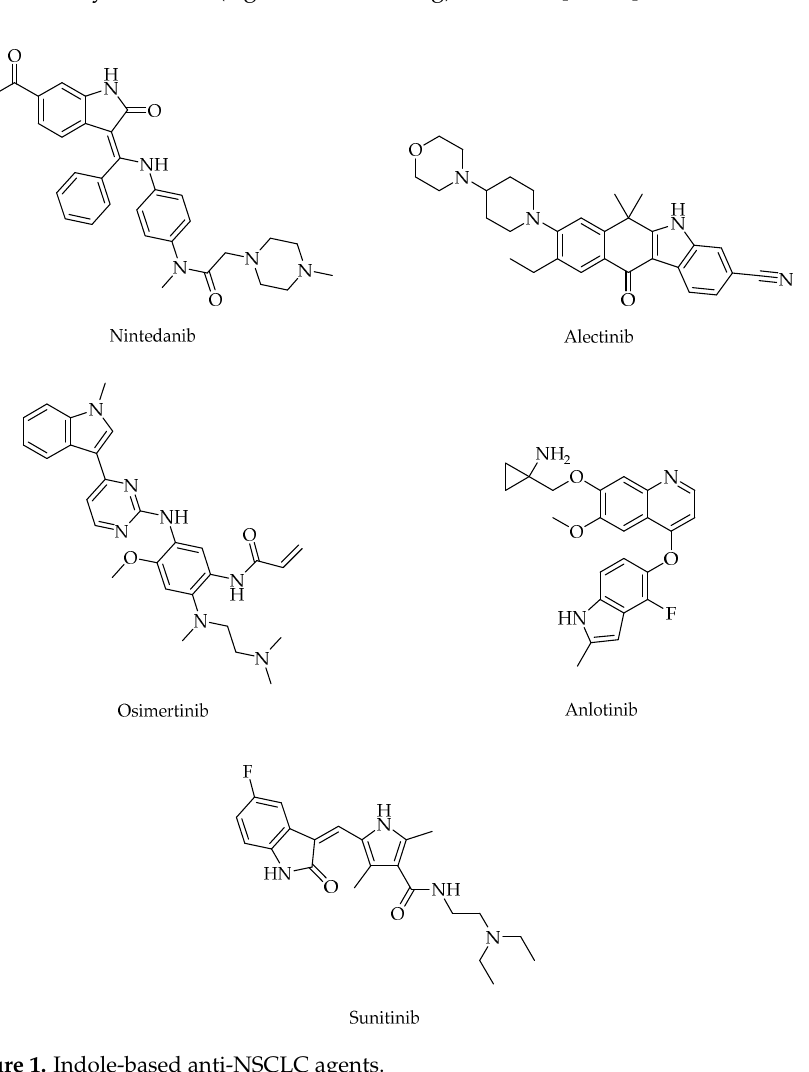
Figure 2. Indomethacin. Taken together, the aforementioned data [26–72] prompted us to design two classes of indole-based small molecules ( 3a-j , 4a-g ) for the targeted therapy of NSCLC. In this context, we performed the synthesis of new hydrazones ( 3a-j ) and thiosemicarbazides ( 4a- g ) efficiently and conducted in vitro and in vivo assays to assess their potential for the targeted therapy of NSCLC.